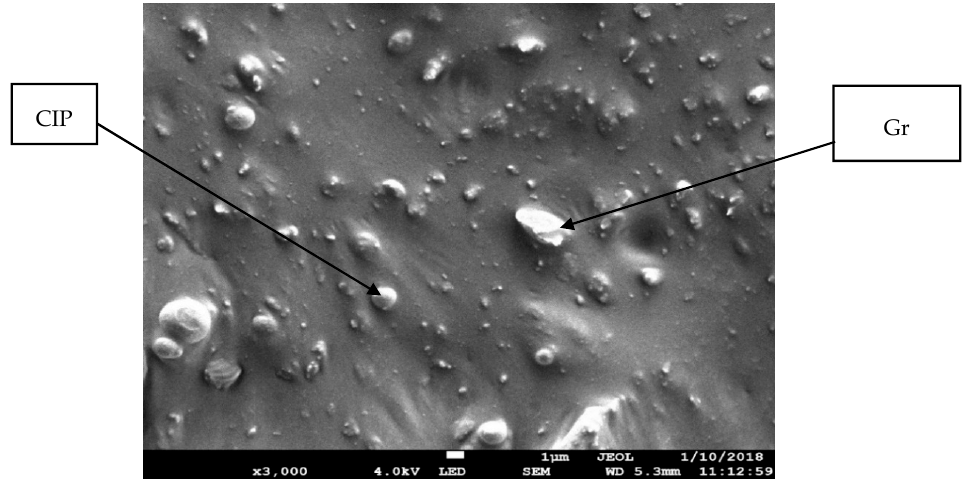
Figure 3. Microstructure of the Gr-MRE (Gr 33%). Gr particles are irregular, while CIPs have a spherical shape.